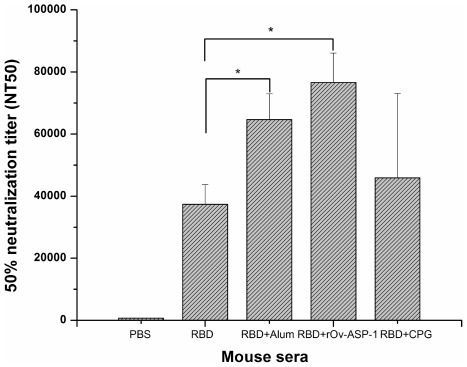
Neutralizing antibody titers induced in vaccinated mice.Neutralization of SARS pseudovirus infection by mouse antisera from each rRBD immunization group 10 days after second boost. Infection of 293T/ACE2 cells by SARS pseudovirus was determined in the presence of antisera at a series of 2-fold dilutions, and 50% neutralization titer (NT50) was calculated for each sample. * indicates significant difference (p<0.05).